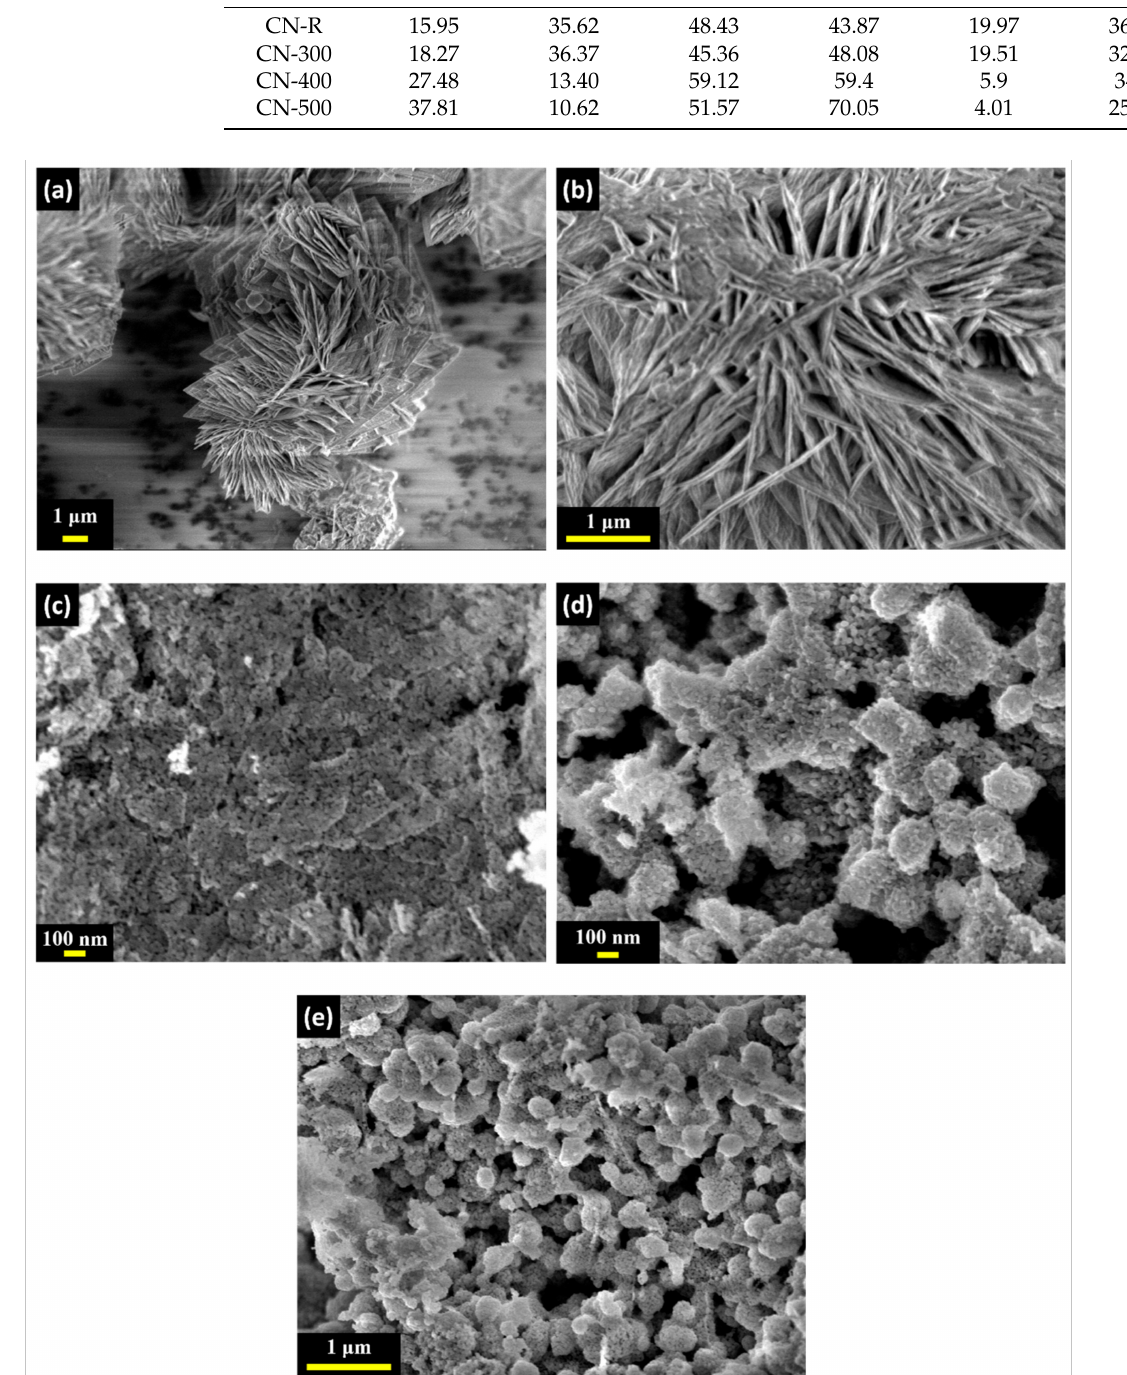
Figure 4. FESEM image for ( a , b ) CN-R, ( c ) CN-300, ( d ) CN-400, and ( e )